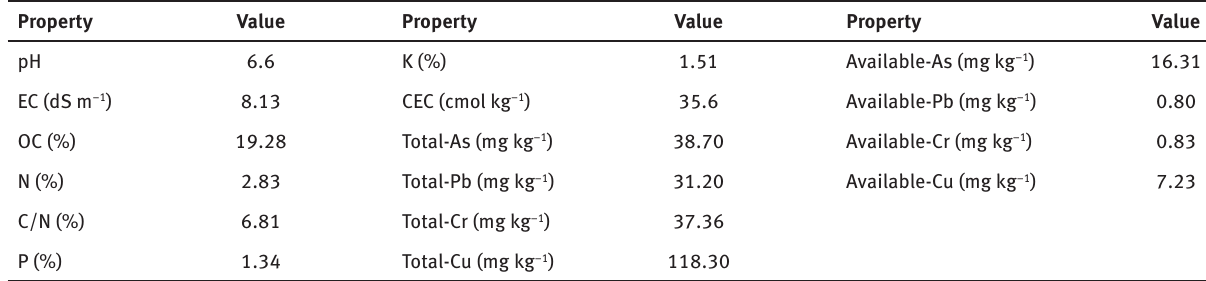
Bulking agents Tree leaves Wheat straw Pistachio hull